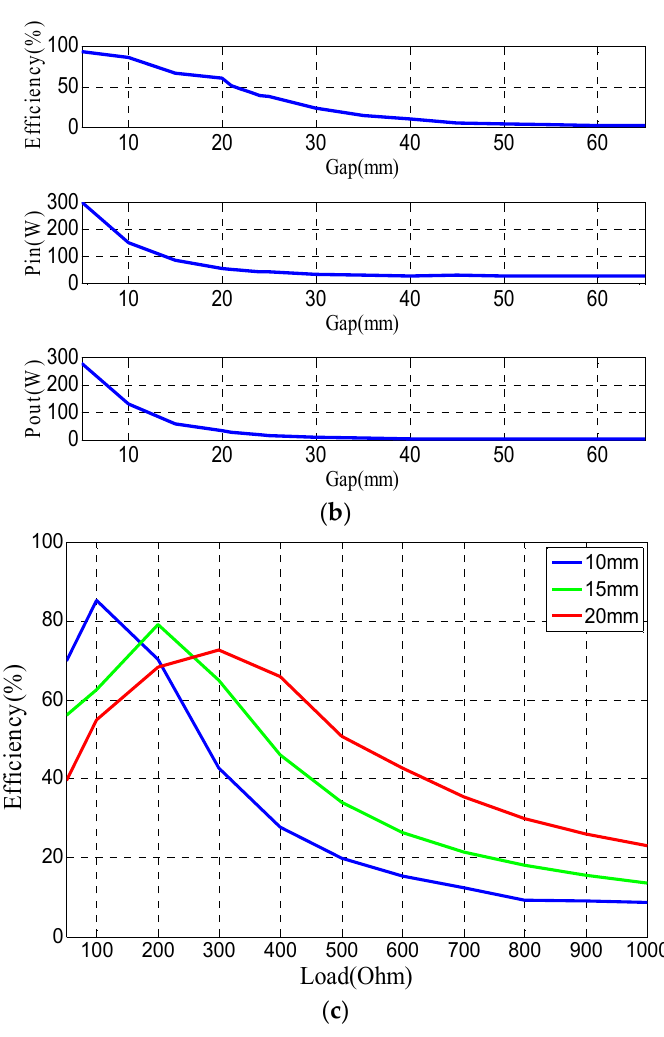
Figure 5. Efficiency, input power, and output power of the P topology IPT system with varied air gap and frequency (V dc : 150 V; R L : 100 Ω ). ( a ) Efficiency, input power, and output power; ( b ) Varied air gap from 5 mm to 65 mm (20 kHz); ( c ) Varied load (20 kHz). Table 3. Efficiency, input power, and output power of the IPT system with varied air gap at 20 kHz.